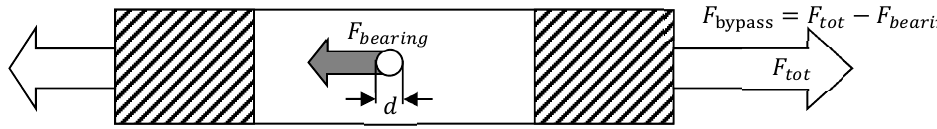
Figure 5. Bolted joint bearing bypass load transfer schematically represented.